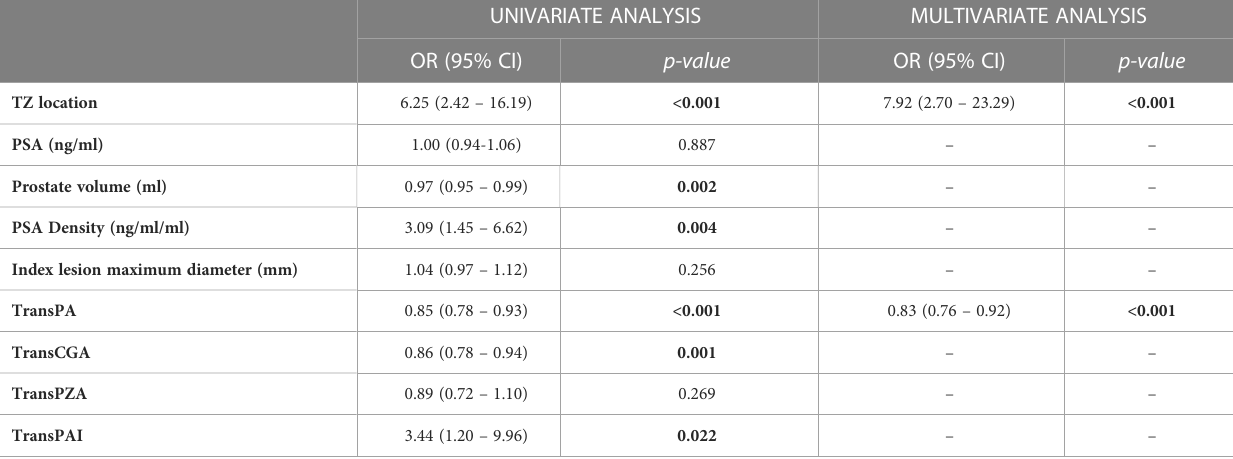
TABLE 3 Univariate and multivariate analyses to predict the presence of PCa at fusion-TB in the overall population of patients with PI-RADS 3 lesions.